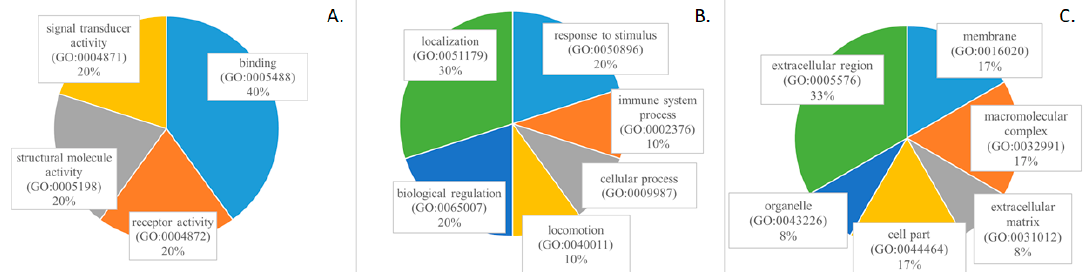
Figure 3. Gene ontology analysis of the most discriminative 11 proteins identified in iTRAQ analysis based on PANTHER database, including: ( A ) molecular function; ( B ) biological process; and, ( C ) cell component.